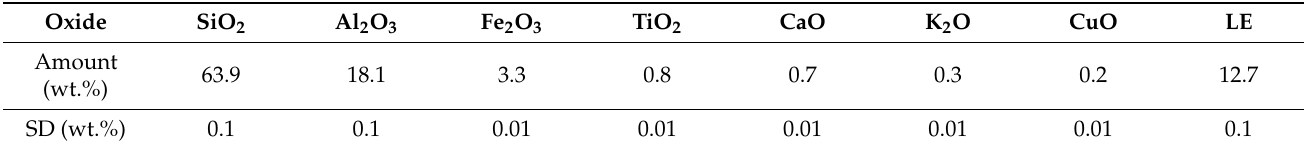
Table 1. Oxide composition of waste diatomaceous earth.